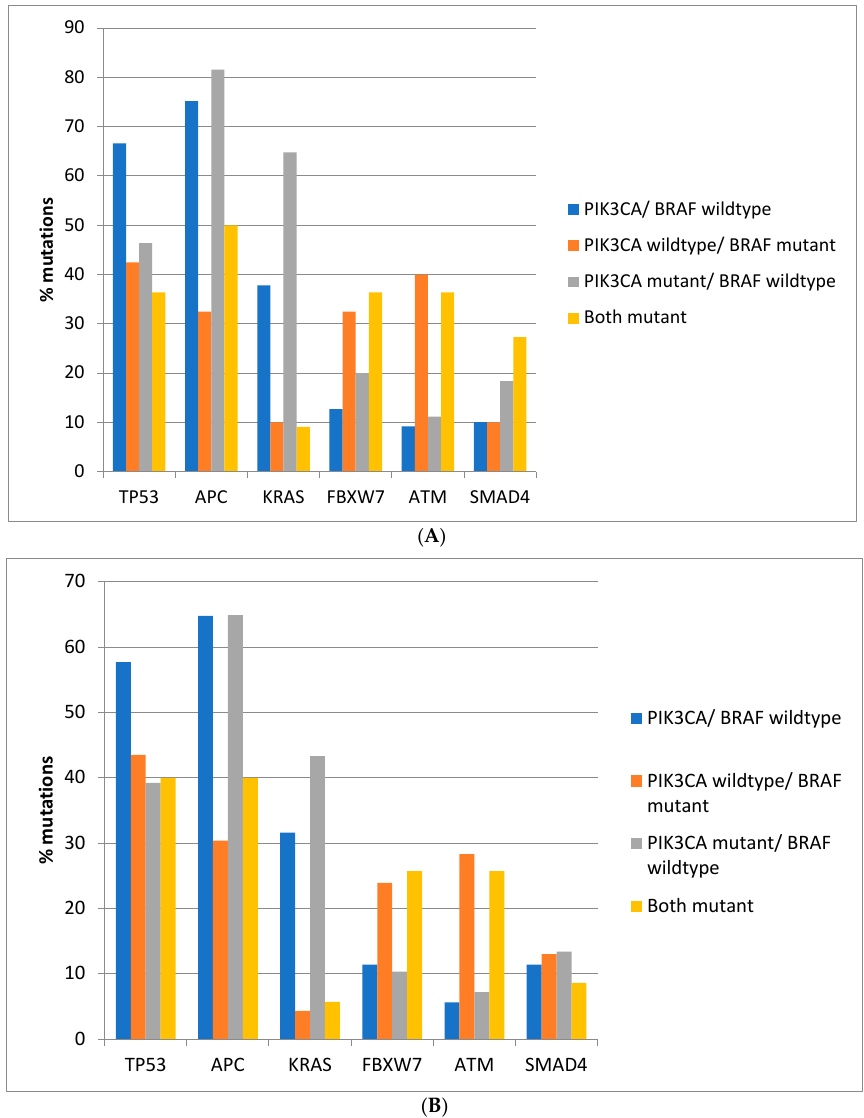
Figure 2. Prevalence of mutations in cancer-associated genes frequently mutated in colorectal cancer in colorectal cancer patients with or without BRAF and PIK3CA mutations. ( A ) TCGA cohort. ( B ) DFCI cohort.